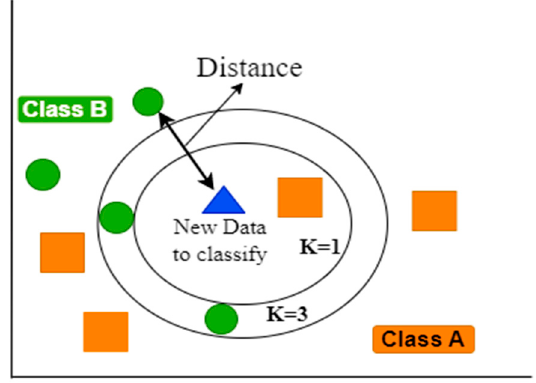
Figure 5. Basic structure of KNN.